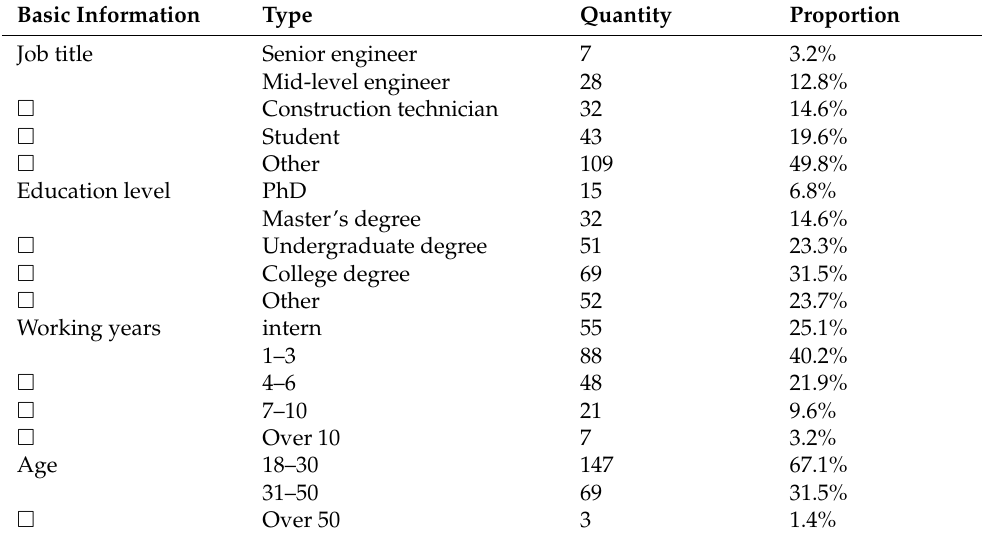
Table 3. Questionnaire sample data